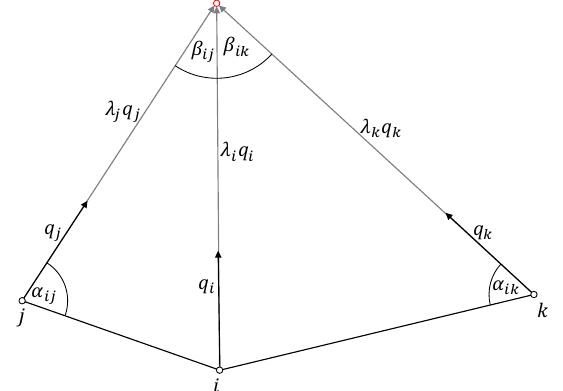
Figure 4. Three cameras 𝑖 , 𝑗 and 𝑘 casting rays 𝑞 towards an observed object point as in Figure 1. Here, angles 𝛼 between base lines and image rays and angles 𝛽 for intersection angles between observations are added.